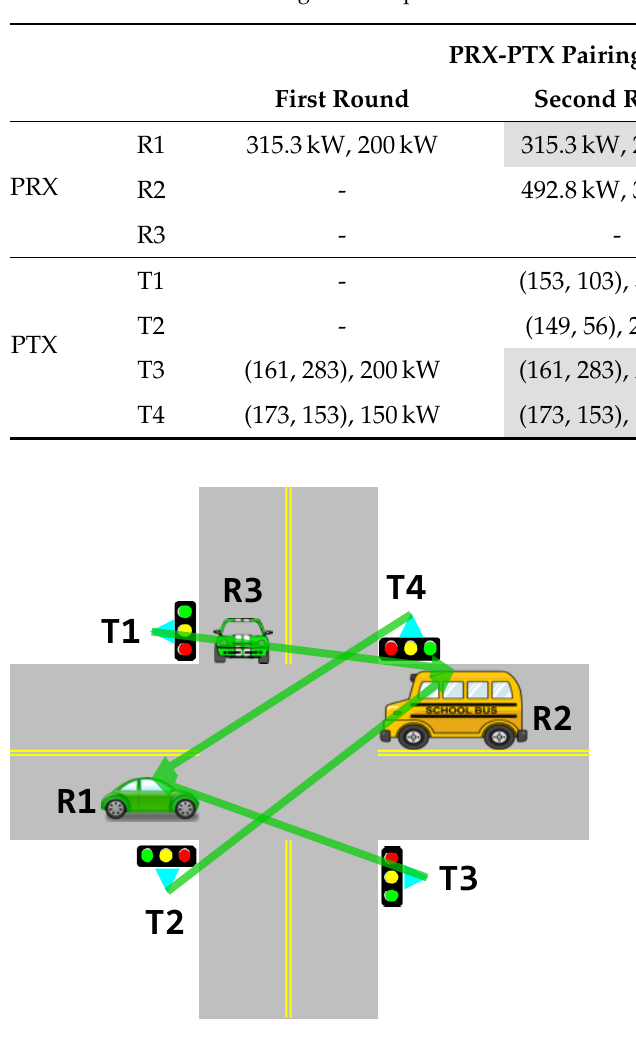
Figure 15. Results of power transmission path